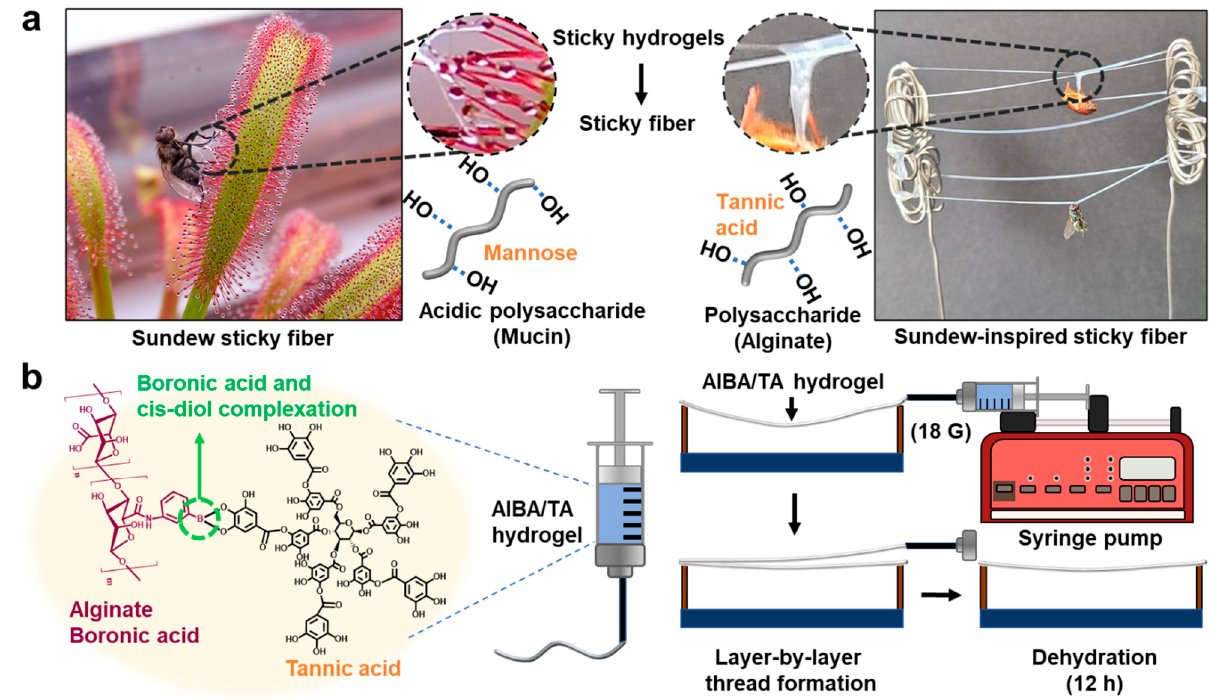
Figure 1. ( a ) Schematic of a hydrogel formed from sundew and an AlBA/TA hydrogel inspired by it. It is composed of mono-/polysaccharides, which are the main components of the sticky hydrogel, and a crosslinking agent that helps the shape to be thread-like. ( b ) The chemical structure of the complexation between boronic acid and cis-diol in TA ( left ) and overall scheme for the manufacturing process of the AlBA/TA hydrogel threads ( right ).